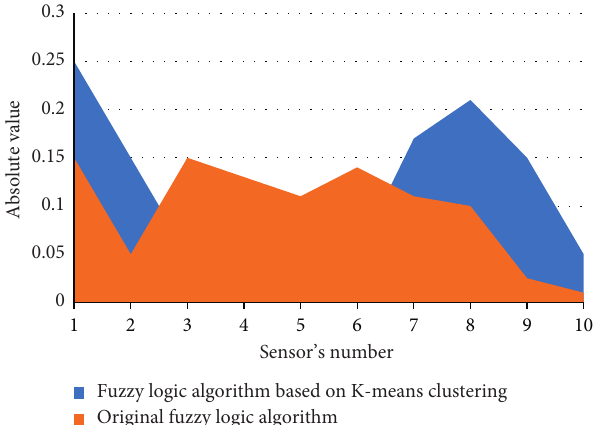
Figure 4: Comparison of improved algorithm and original algorithm.